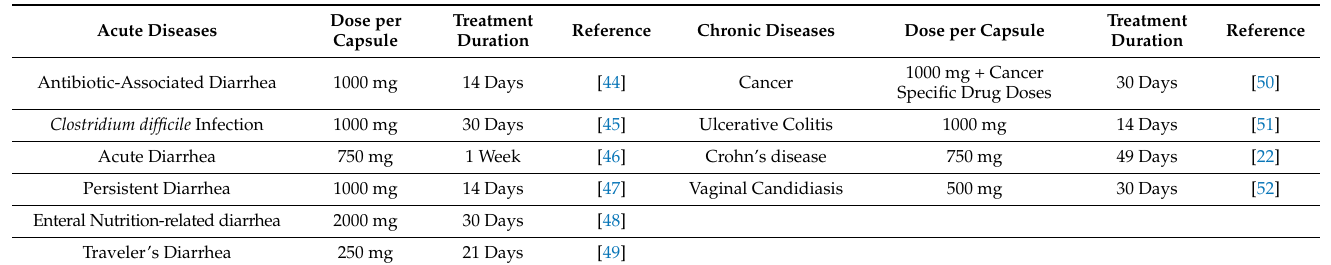
Table 3. Per capsule/tablet dose of S. cerevisiae var. boulardii for the treatment of different acute and chronic diseases.